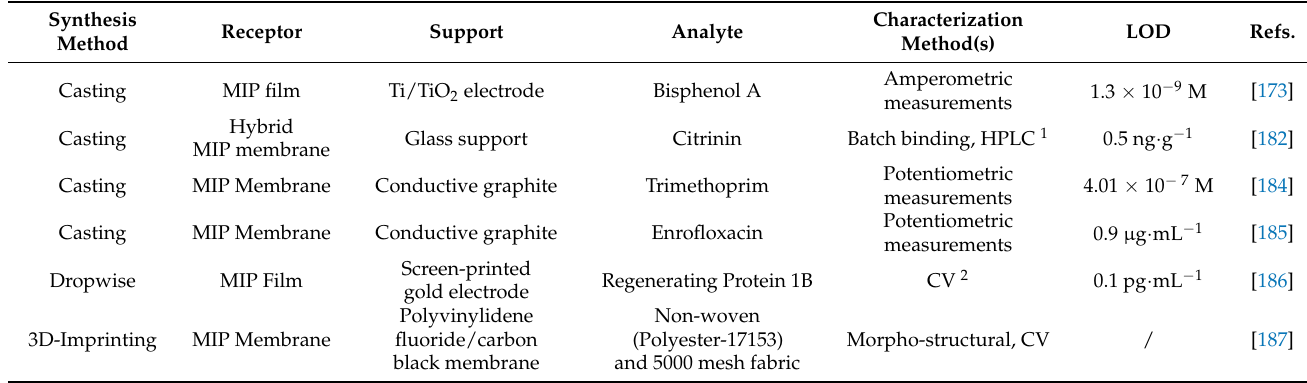
Table 5. MIP-based sensors obtained by phase inversion